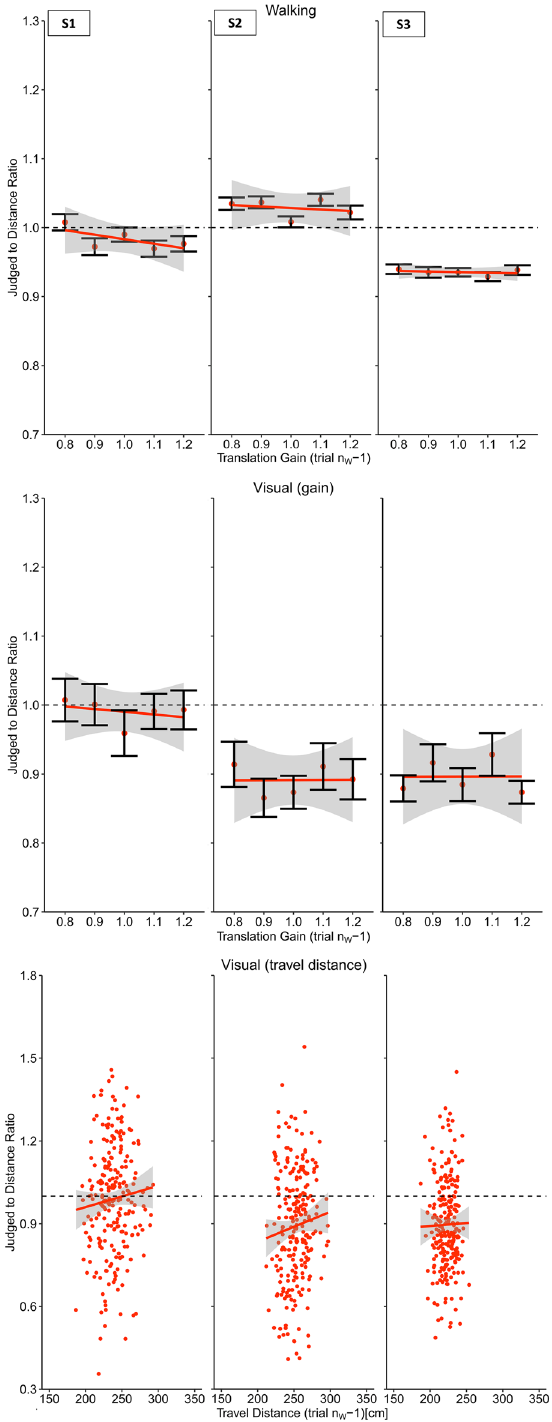
Figure 5. Results of Experiment 3 (physical walking without optic flow) for three example participants. Upper panel: Regression between the translation gain in trial n W and judge to distance ratio for walking distance estimations in trial n W − 1. Middle panel: Serial dependencies quantified by the regression between the translation gain in in trial n w − 1 and visual distance judgements. Lower panel: Serial dependencies quantified by the regression between travel distance in trial n w − 1 and visual distance judgements. Error bars represent the SEM and the grey areas represent the 95% confidence